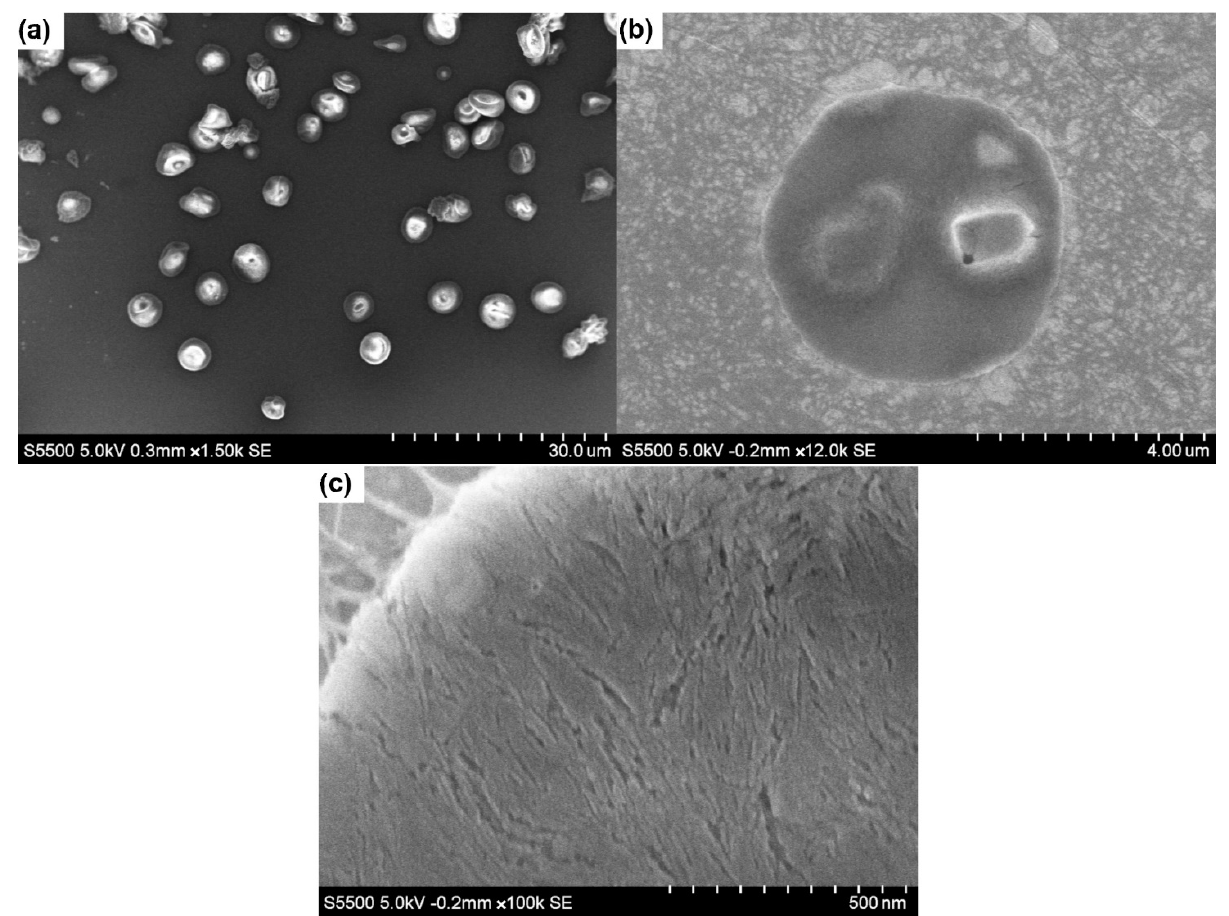
Figure 8. SEM images of n-heptane emulsions prepared using 1:1 ChNC-CNC nanoconjugates and dried using critical-point drying. ( a ) Multiple droplets observed; ( b ) an approximation onto a single nanoparticle crust; ( c ) a region where individual nanocrystals are oriented in a preferred direction.